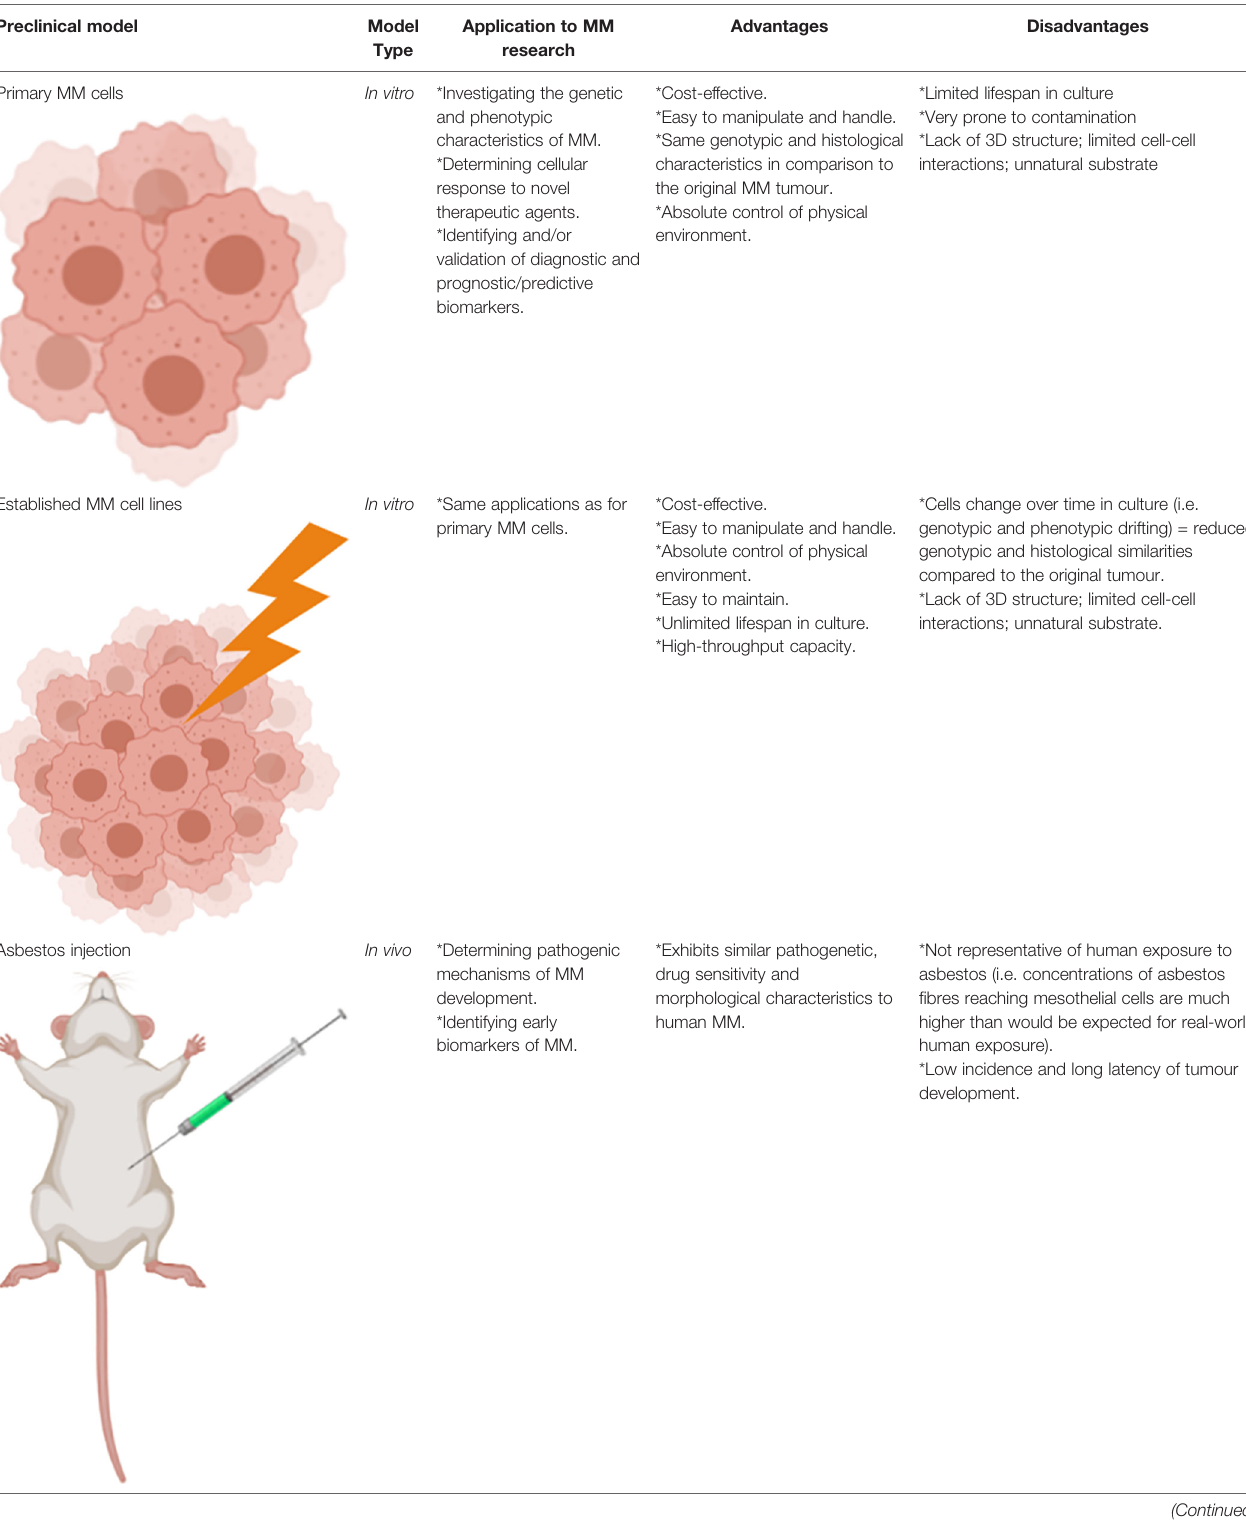
TABLE 1 | Summary of the types of in vitro and in vivo preclinical models of MM, their applications to research and their main advantages and